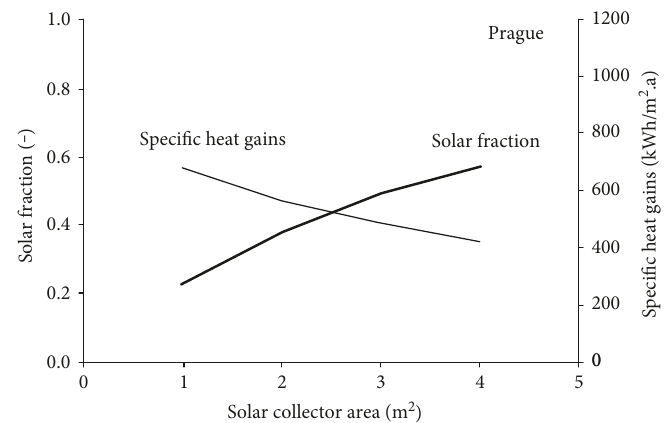
Figure 9: Performance characteristics of solar photothermal hot water systems in the climate of Prague.